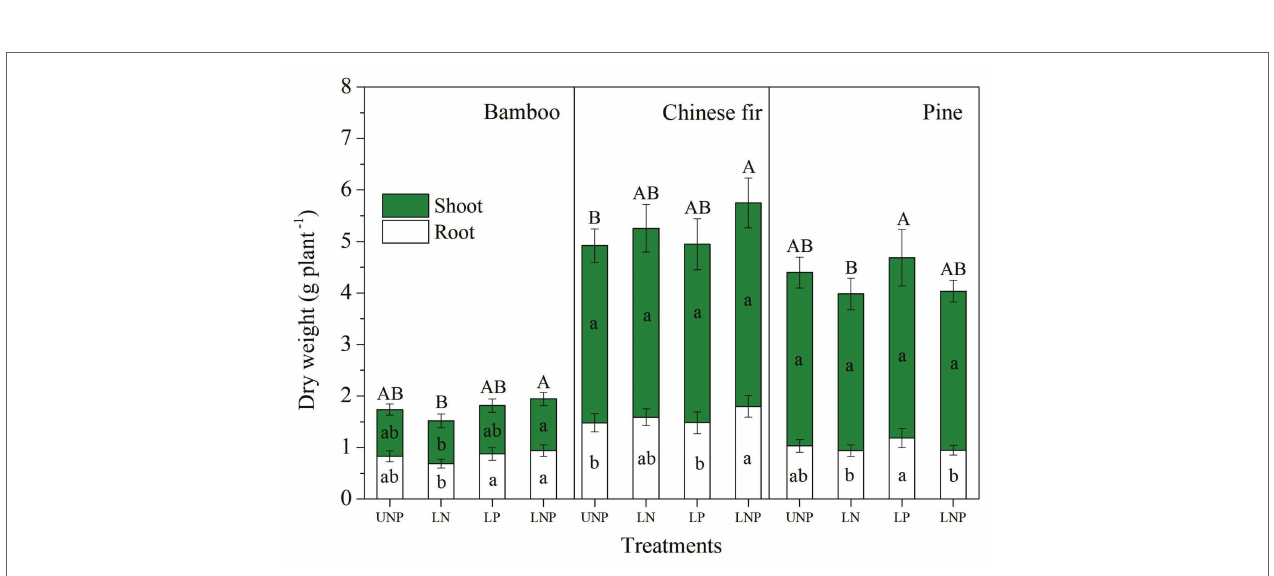
FIGURE 4 | Shoot and root biomass of the three tree species in relation to different nutrient supply treatments. Different lowercase letters denote significant differences in shoot or root biomass within each species among treatments ( p < 0.05), and different capital letters denote significant differences in total plant biomass within each species among treatments ( p <